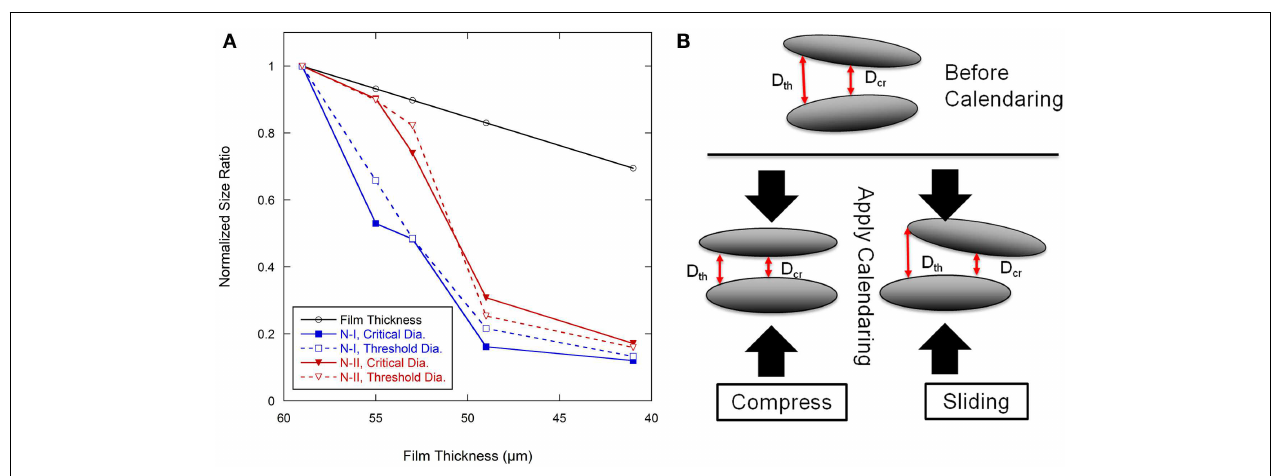
FIGURE 8 | (A) Pore size ratio of calendered films to pore size in 59 µ m baseline anode films, and film thickness change with calendering force. (B) Schematic showing the pore size and geometry change with calendering force in graphite anode